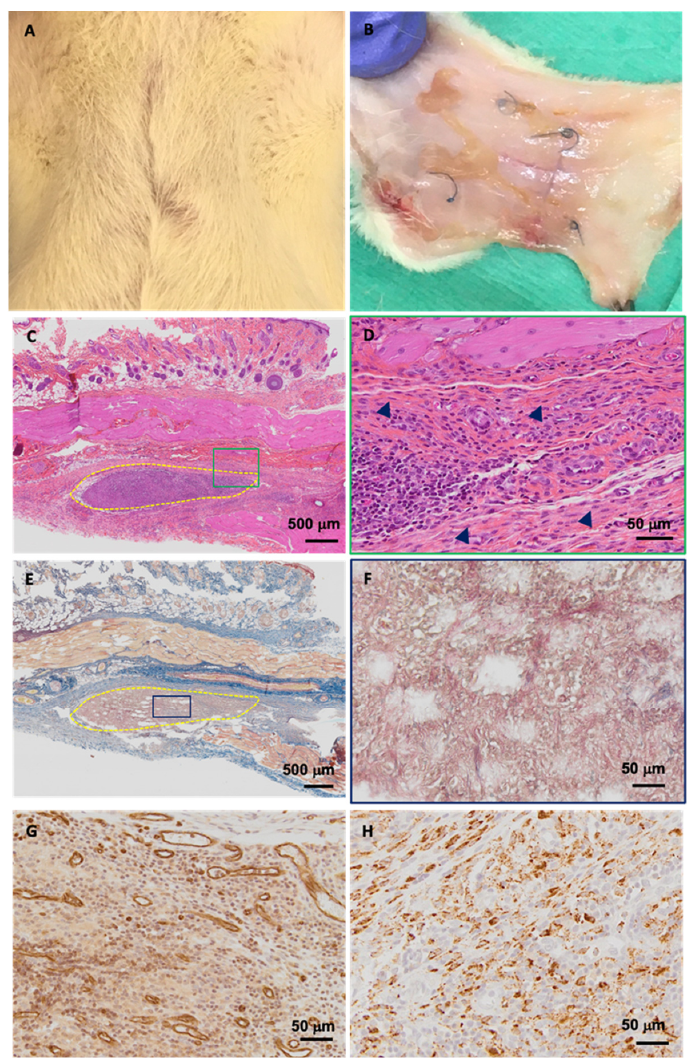
Figure 7. Subcutaneous biocompatibility of decellularized Wharton’s Jelly. ( A , B ): Macroscopical examination of the wound recovery and explanted tissue, respectively. ( C , D ): Hematoxylin-eosin-Safran (HES) staining of paraffin-embedded explant (delimited by dashed yellow line) at lower and